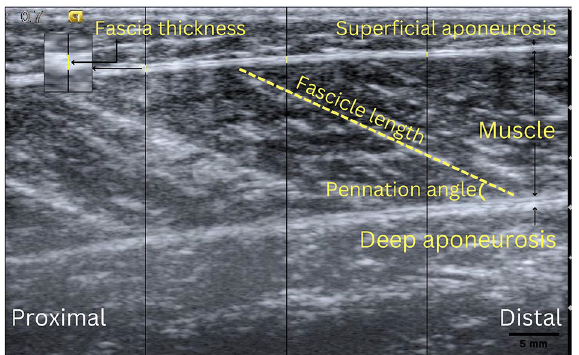
Figure 6. Measurement of fascia thickness, fascicle length and pennation angle.